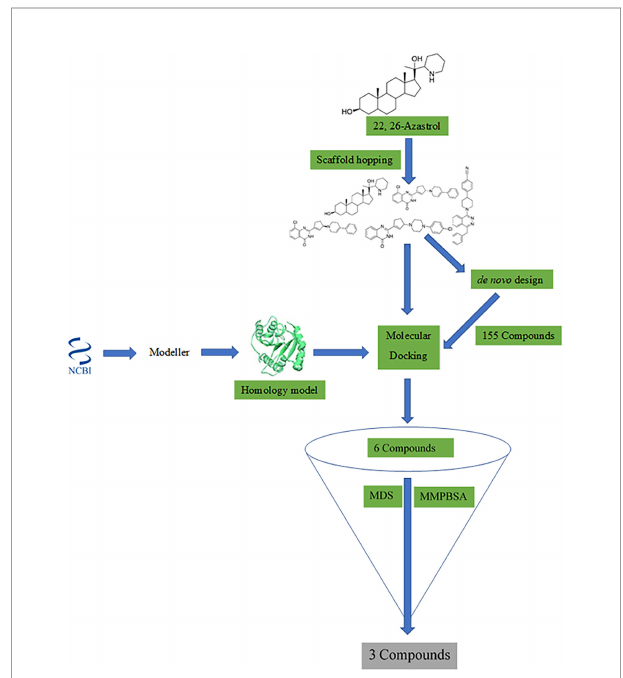
FIGURE 1 | Methodology schema employed in the study for predicting antileishmanial